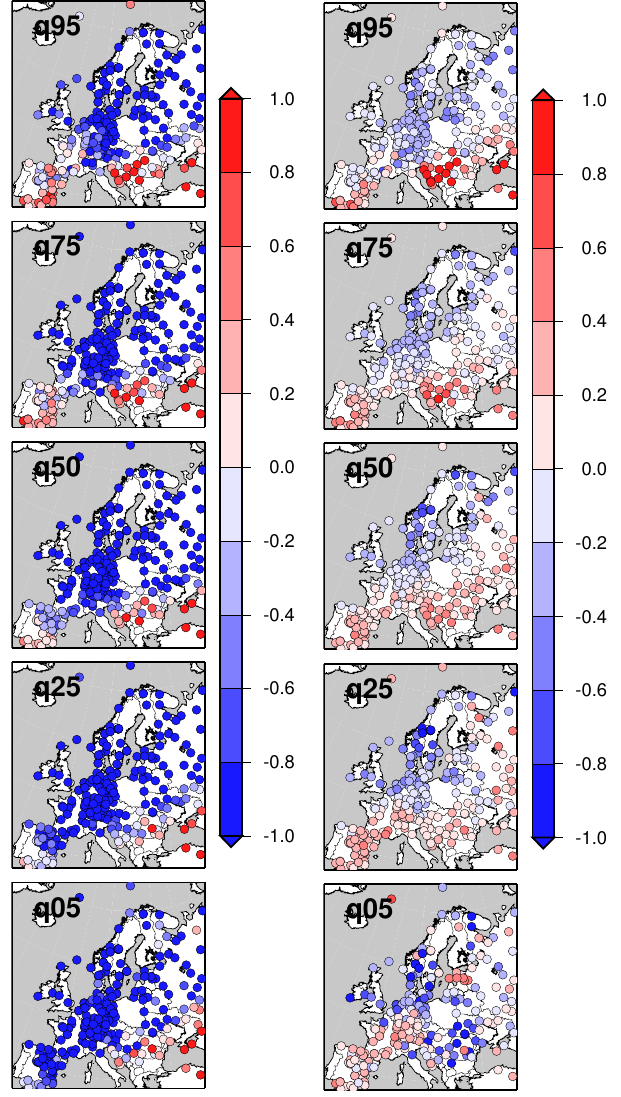
Fig. 9. Left column: differences of quantiles between mean ob- served and simulated temperature anomalies with “static” weather generator for the winter of 2009/2010 (initiated on the 21 Decem- ber 2009). Right column: differences of quantiles between mean observed and simulated temperature anomalies with “dynamic” weather generator with a 21 December 2009 initialisation.